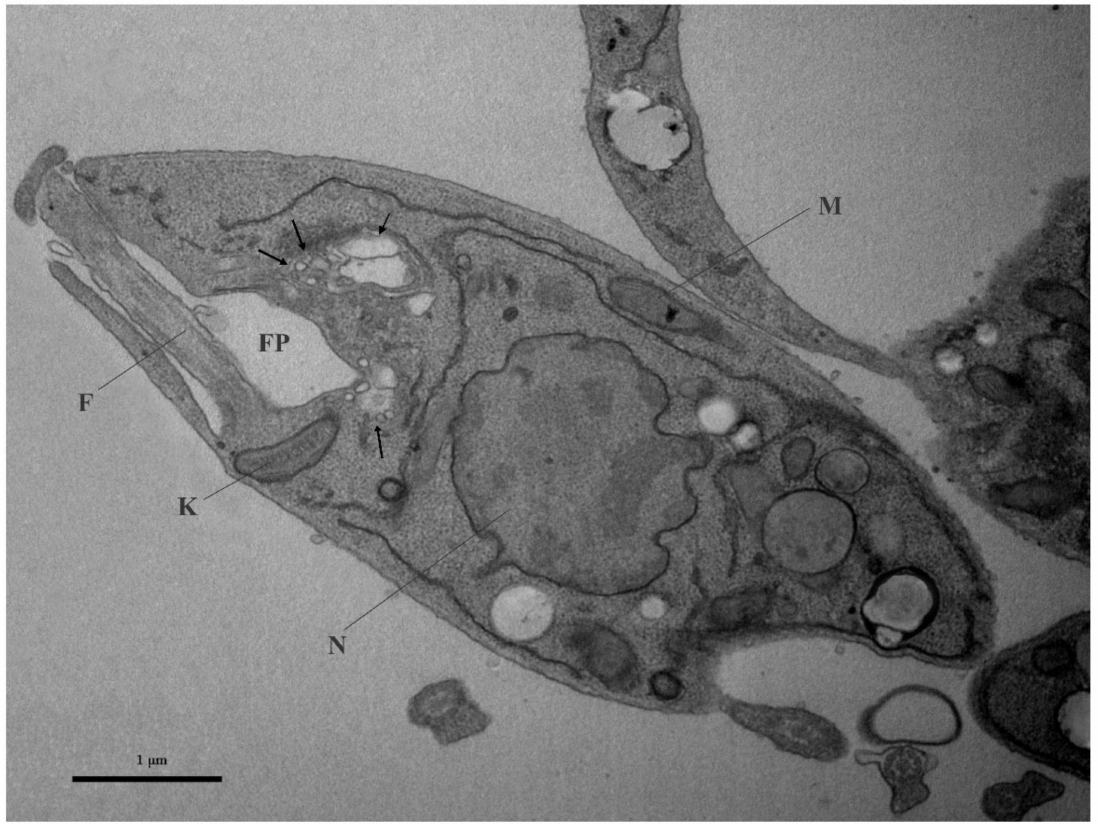
Figure 3. The tubular structures and vesicles (arrows) that participate in the processes of endocytosis and exocytosis can be seen in the flagellar pocket of the Leishmania ( L .) amazonensis promastigotes (MHOM/BR/2009/M26361 strain). F = flagellum; K = kinetoplast; M = mitochondrion; N = nucleus. Scale bar = 1 µ